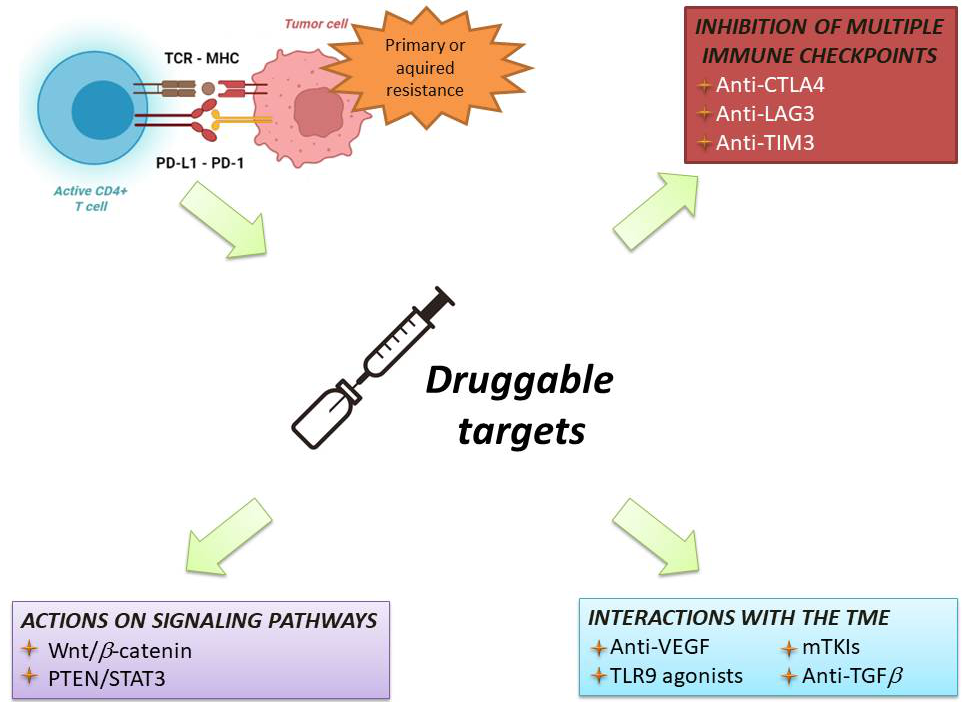
Figure 4. Overview of current therapeutic strategies to overcome resistance to immunotherapy. MHC: major histocompatibility complex; TCR: T-cell receptor; CD: cluster differentiation; PD-1: programmed death-1; PD-L1: programmed death 1-ligand. CTLA-4: cytotoxic T lymphocyte-associated protein 4; TME: tumour microenvironment; LAG3: lymphocyte-activation gene 3; TIM3: T-cell immunoglobulin and mucin domain 3; VEGF: vascular endothelial growth factor; TLR9: Toll-like receptor-9; mTKIs: multitarget tyrosin kinase inhibitors; TGFb: transforming growth factor-beta.